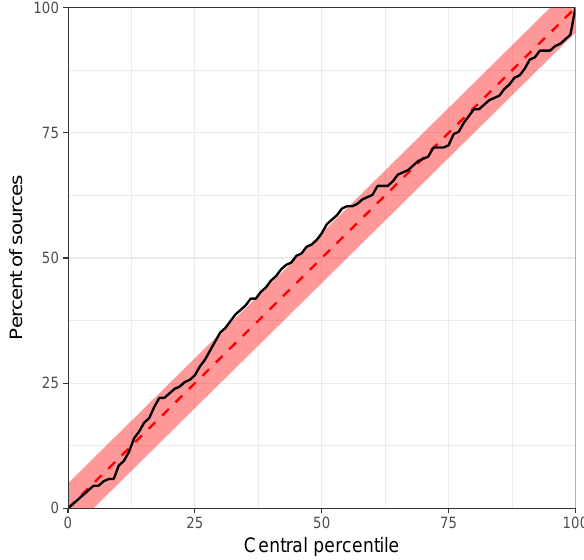
Fig. 7.— Percentage of sources in the primary sample whose predicted flux at epoch 2 fell within a given central percentile of √ a lognormal distribution with σ = 0 . 43 2 centred on the flux at epoch 1. The solid line shows the data, while the dashed line shows the expected one-to-one correspondence if the model perfectly pre- dicted the data. The shaded region encloses plus or minus five percentage points around the model